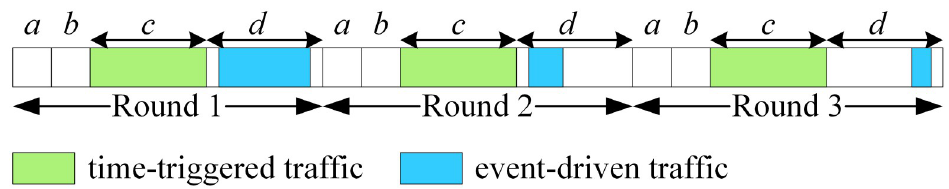
Fig 6. Periodical structure of TD-IMOCRP if event-driven data transmission can be finished in one-round period.